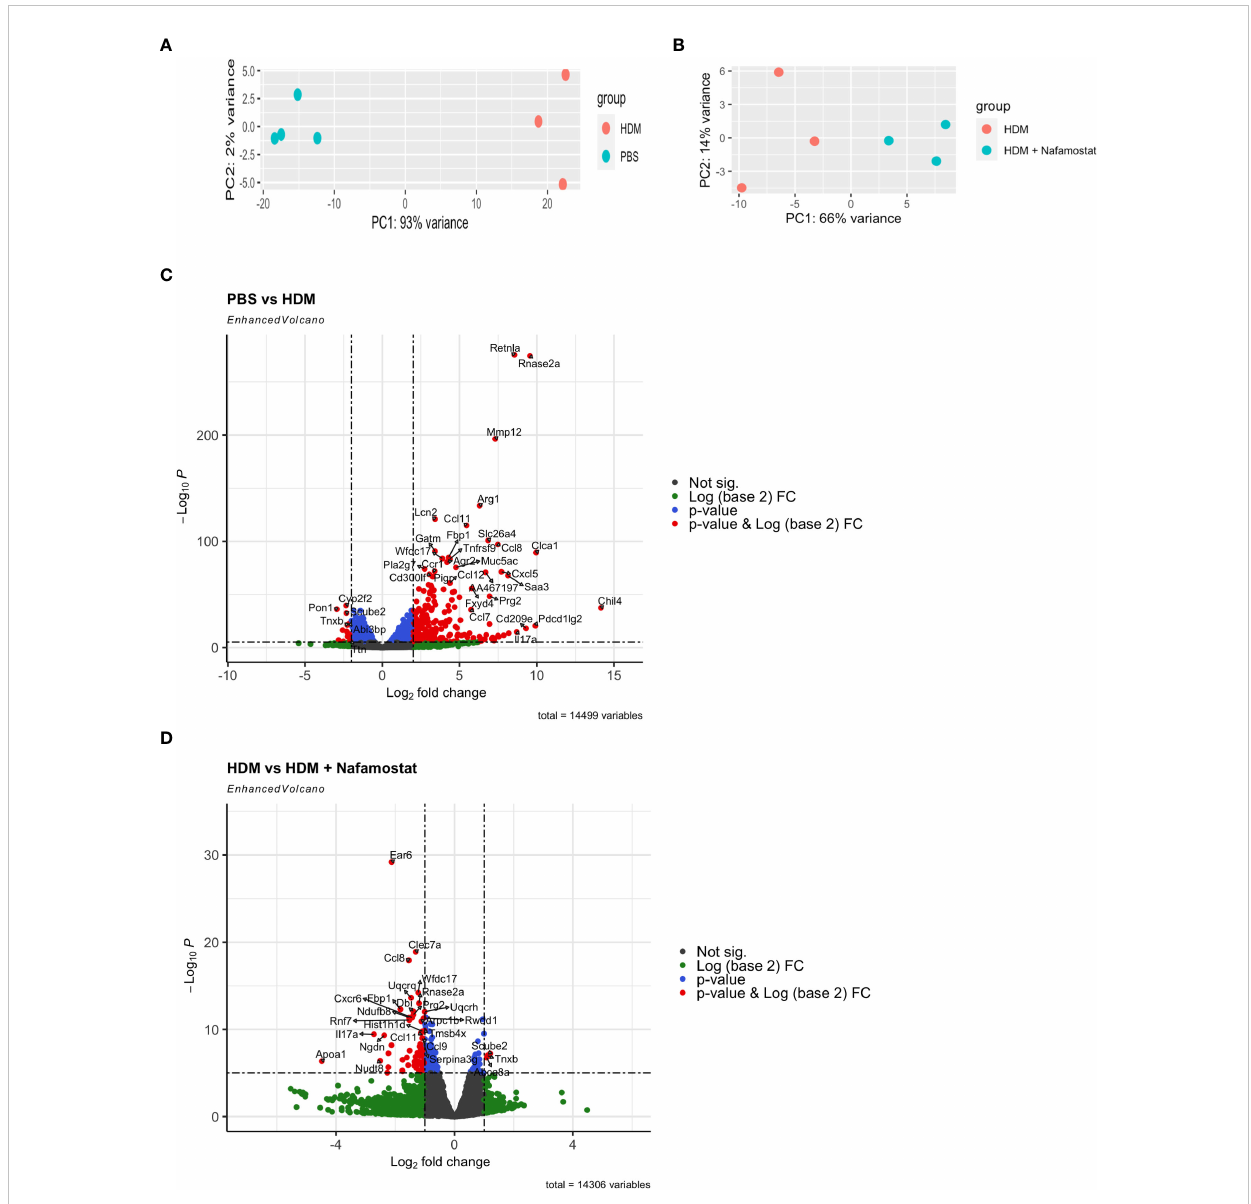
FIGURE 5 Effect of nafamostat on gene expression in lungs from mice subjected to HDM-induced experimental asthma. (A, B) Principal Component Analysis (PCA) of the comparison between the control- (PBS) vs. HDM (A) and the HDM vs. HDM + nafamostat (20 mg/kg) (B) groups. (C, D) Comparison of the differentially expressed genes (DEGs) between the control- (PBS) vs. HDM (C) and the HDM vs. HDM + nafamostat (20 mg/kg) (D) groups, by volcano plot analysis using the EnhancedVolcano package of R. Each dot represents a single gene. The x-axis depicts the log (base 2) of the fold change (FC), while the y-axis represents the negative log (base 10) of p-value. DEGs were identi fi ed as p < 0.05 and log2 FC ≥